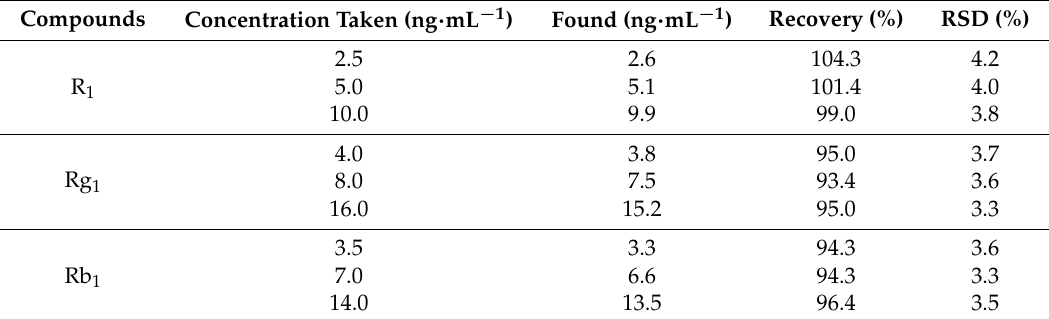
Table 4. Spiked recoveries of R 1 , Rg 1 and Rb 1 in plasma samples ( n = 3).